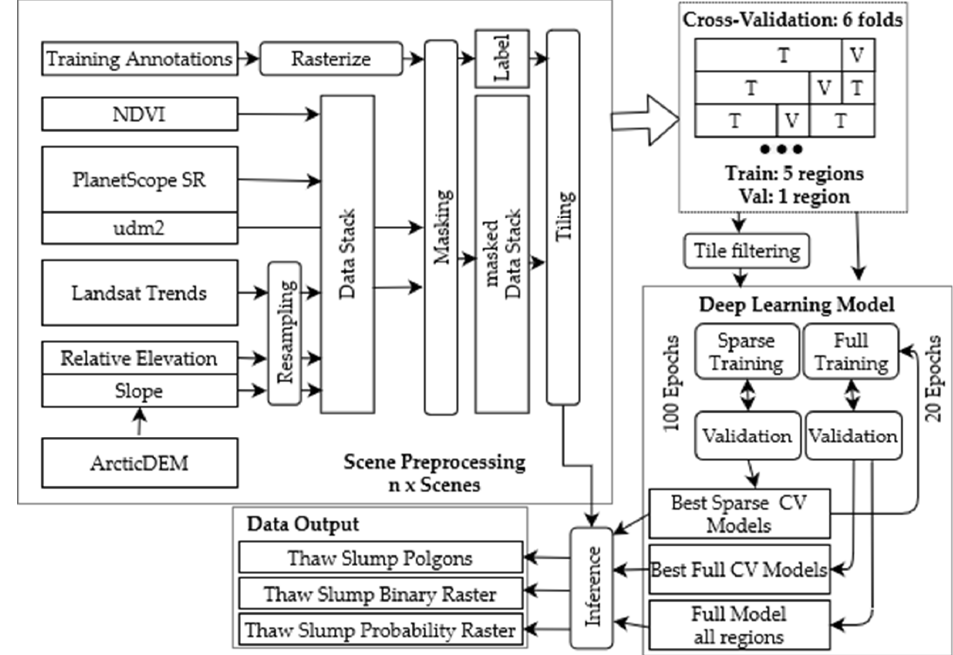
Figure 3. Flowchart of the full processing pipeline. Table 3. List of model input data layers, with preprocessing status, native resolution and number of bands.